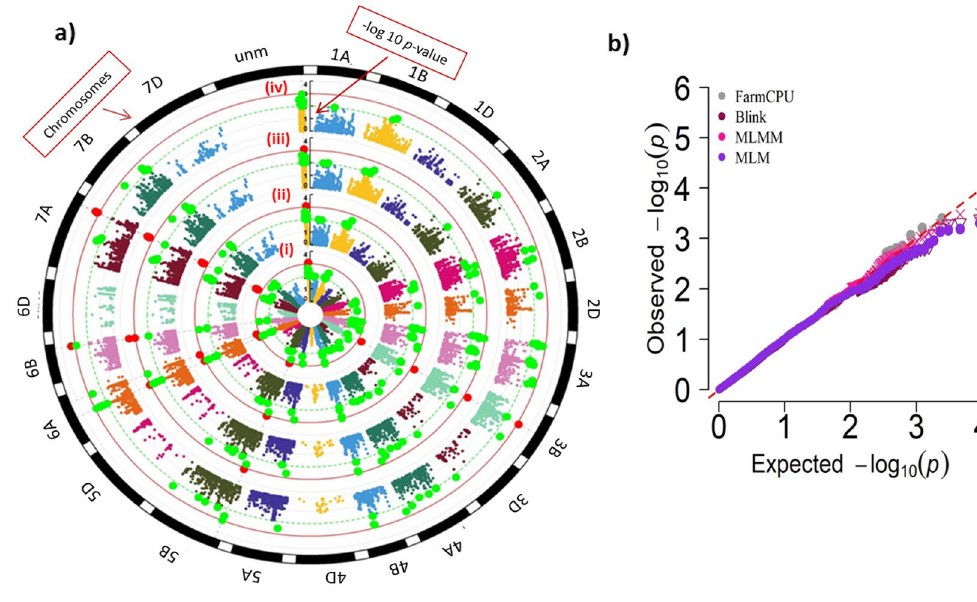
Figure 4. ( a ) Circular Manhattan plot representation of four different models used for GWAS analysis (i) BLINK, (ii) FarmCPU, (iii) MLM and (iv) MLMM ( b ) Combined QQ-plot of the observed and the expected p -values using different GWAS models.